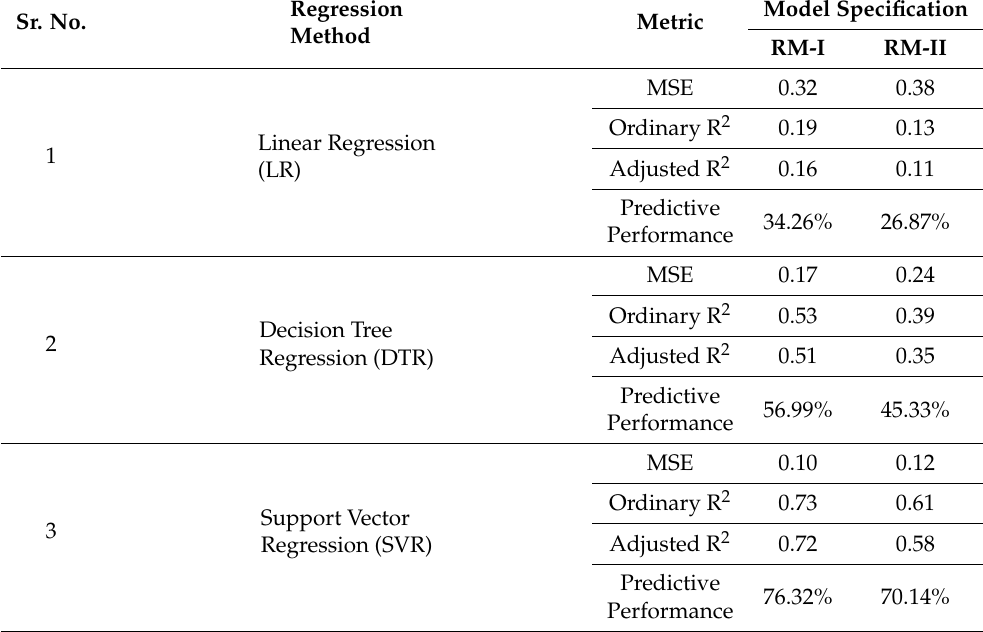
Table 7. Results for general analysis – Case 2: building a common model for both dehydration and rehydration phases (RM-I: regression models built using ∆ F 1 t , ∆ F 2 t , ∆ F 3 t , and ∆ F 4 t as predictors; RM-II: regression models built using ∆ PV t and ∆ USG t as predictors). Sr.